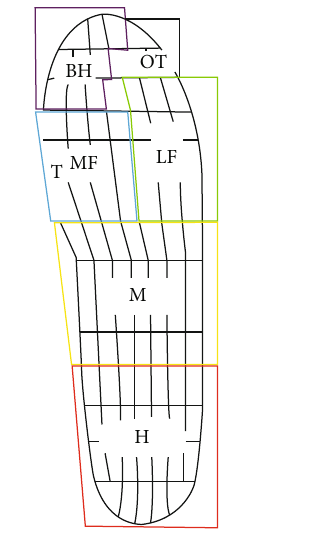
Figure 4: The schematic diagram of the plantar zones division (BH: hallux; OT: other toes; MF: medial foot; LF: lateral foot; M: midfoot; H: heel).